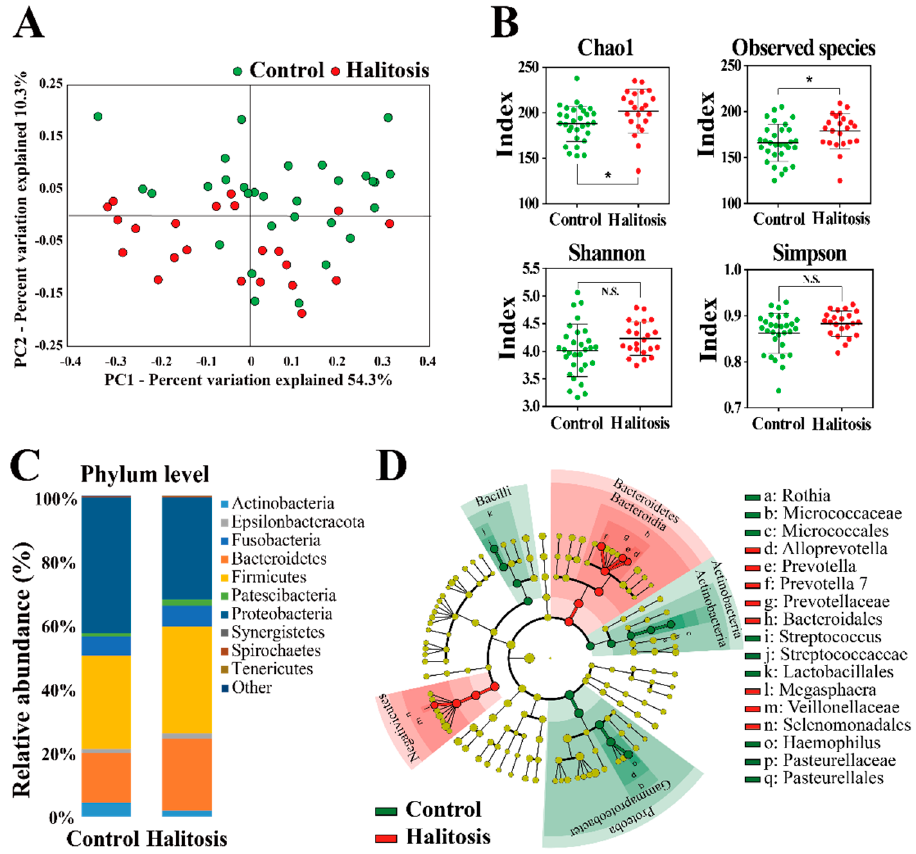
Figure 1. Comparison of the diversity and taxonomy of salivary microbiota according to halitosis. ( A ) The principal coordinates analysis (PCoA) based on the Bray-Curtis distances of salivary microbiota between the control and halitosis groups. ( B ) Comparison of the alpha diversity of salivary microbiota between the control and halitosis groups. ( C ) Comparison of the microbiota composition between the control and halitosis groups at the phylum level. 16S rRNA gene sequences were clustered into the operational taxonomic units (OTUs) based on 97% identity. OTUs with >1% relative abundance are represented in the phyla. ( D ) Cladogram showing the most discriminative bacterial clades identified using linear discriminant analysis effect size (LEfSe). Colored region/branches indicate differences in the bacterial population structure between the control group and the halitosis group. Sectors in green indicate clades that are enriched in the control group compared with the halitosis group, whereas sector in red indicates clades that are enriched in the halitosis group compared with the control group. * p < 0.05, N.S., Not